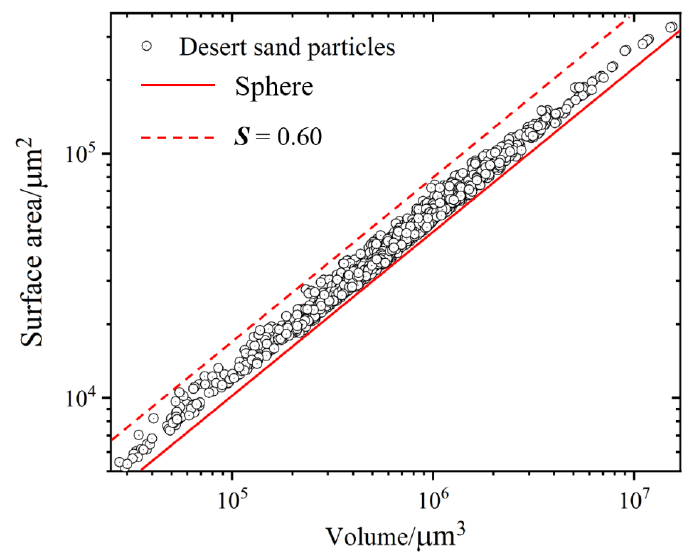
Figure 8. Relationship between volume and surface area of desert sand